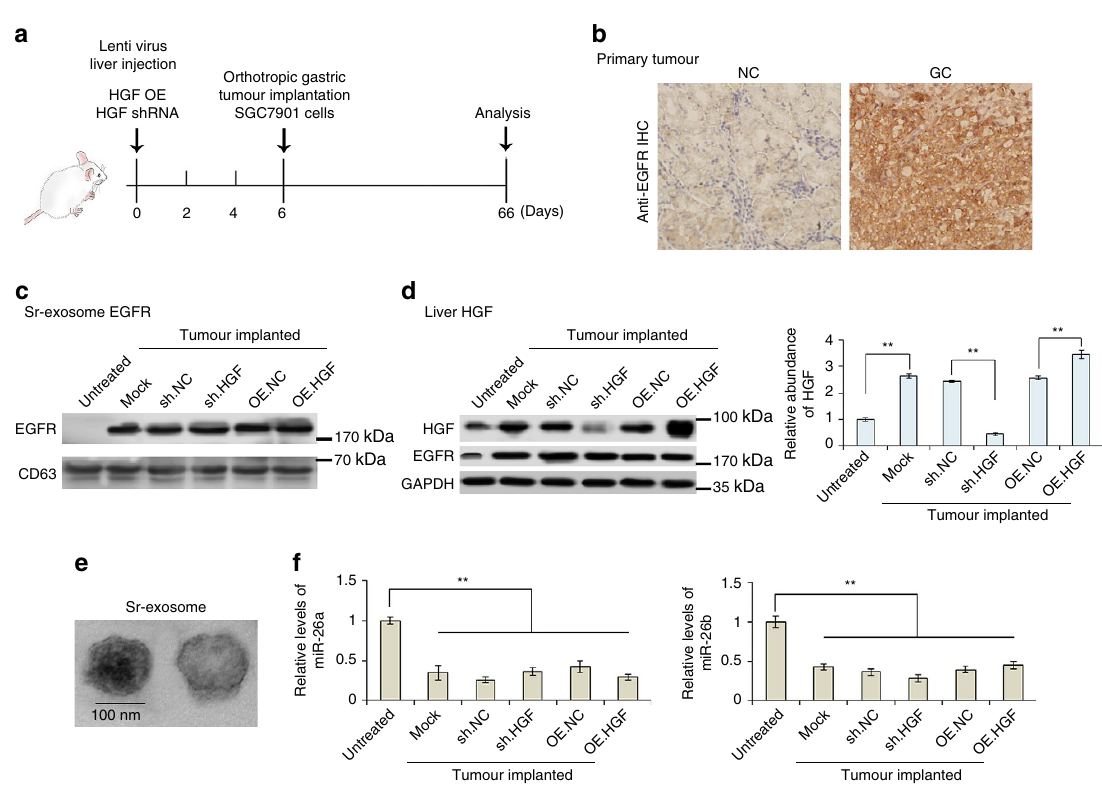
Figure 7 | In vivo verification for exosome-EGFR activates liver HGF by inhibiting miR-26a/b. The livers of mice were pre-treated with HGF shRNA or HGF overexpressing lentivirus by multi-point injection, followed by orthotopic tumour implantation on the 6th day; finally, mice were killed and data were analysed on the 66th day. ( a ) A flow chart depicting the in vivo experimental design. ( b ) Immunohistochemistry (IHC) analysis of EGFR expression in primary gastric tumour. ( c ) Western blotting analysis of exosome EGFR in the serum of tumour-implanted mice ( n ¼ 30). ( d ) Levels of HGF in liver tissues of GC tumour-implanted mice ( n ¼ 30). ( e ) Electron-microscope scanning of exosomes isolated from mouse serum. ( f ) Relative levels of miR-26a/b in mouse liver tissues ( n ¼ 30). The data represent the mean ± s.e.m. ** P o 0.01 (Student’s t